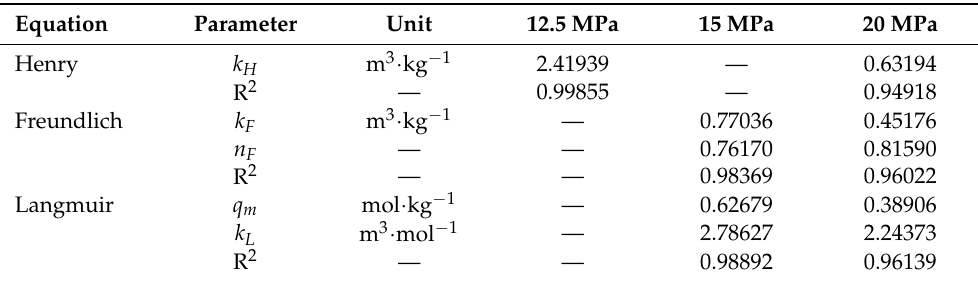
Table 5. Adsorption isotherm parameters for Co(acac) 3 from scCO 2 solution on MCM ‐ 41 at 333 K and different pressures [60].